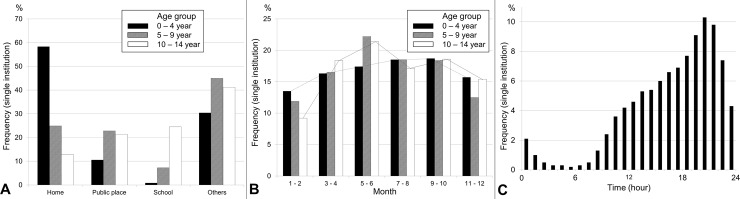
(A) Place of injury by age. The home was the most common location where injury occurred in young children. As age increased, the injury rates outside the home also increased. (B) Monthly visit frequencies by age. The differences in the frequencies of emergency department visits by month became more apparent as age increased. For older children, the visit frequency peaked in May and June, which is a period suitable for outdoor activities. By contrast, the frequency of visits was lowest during winter. (C) Time of emergency department visits. The most common time when emergency departments were visited was between 7 and 10 pm.